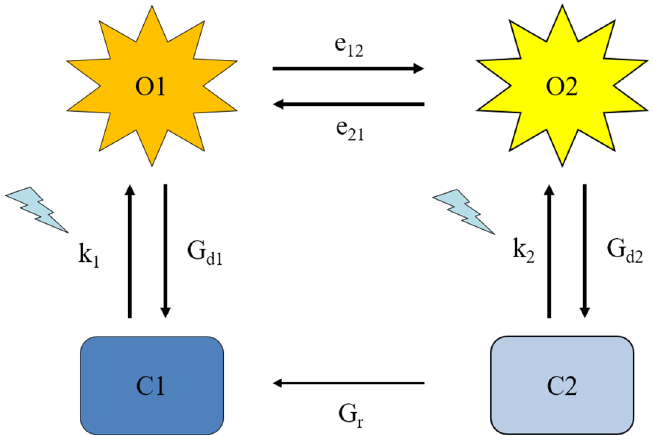
Figure 1. Channelrhodopsin-2 (ChR2) four-state model. Four-state kinetic model of ChR2 with two conducting (O1 and O2) and two non-conducting (C1 and C2) states. Each transition is represented by the corresponding rate parameter used in the kinetic model. The blue arrows represent light-assisted transitions.